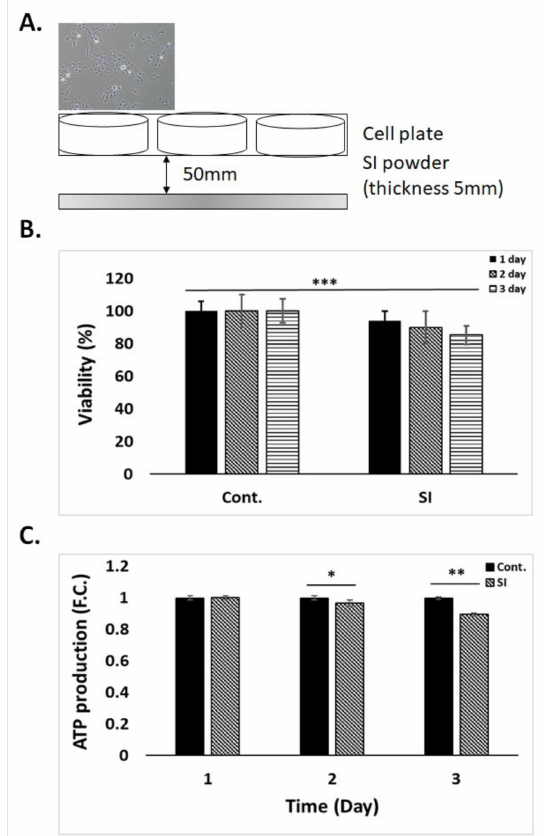
Commented [M5]: There are some traces on the left bottom of Figure 1D(1). Could you please cut it off? Commented [u6R5]: I did it.